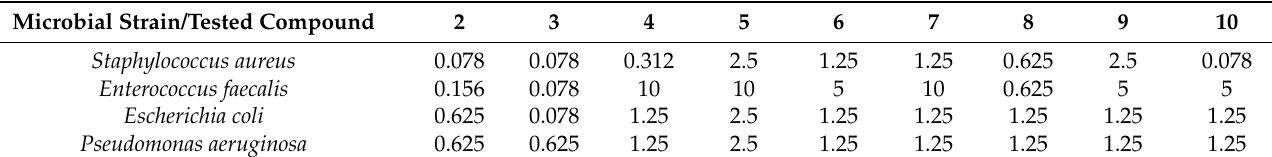
Table 2. The MIC values (mg/mL) of the tested compounds.